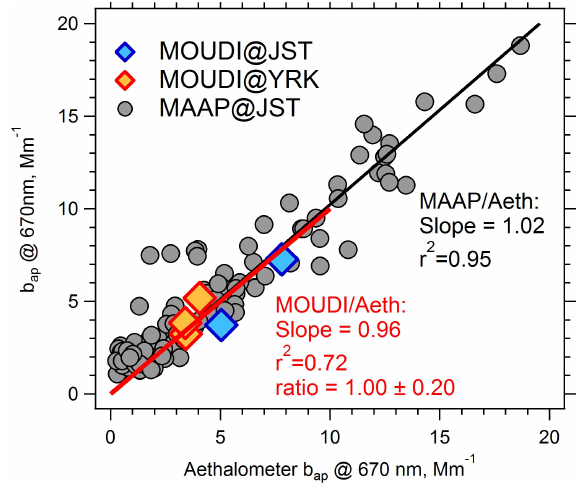
Fig. 1. Comparison of absorption at 670nm between scattering- corrected Aethalometer and MAAP for 1h averaged data (grey filled circles) and Aethalometer absorption averaged over MOUDI sampling times to absorption determined from the EC size distribu- tion and Mie theory (diamonds). An orthogonal distance regression (ODR) fit was